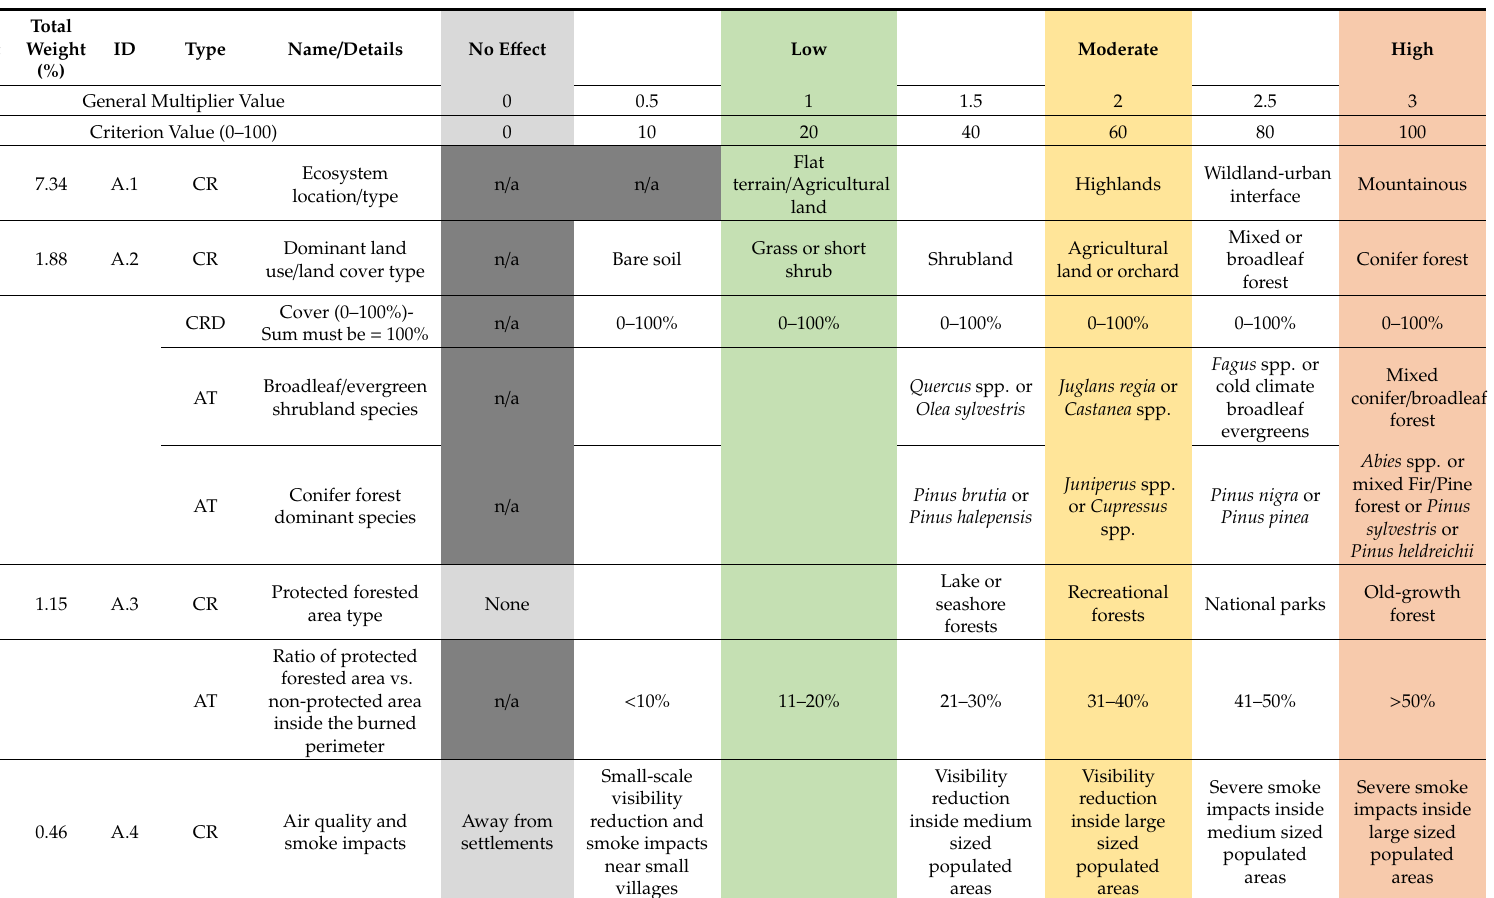
Table A1. Criteria, choices, and weights for the e ff ects on landscape and vegetation fire e ff ects category. CR: criterion; CRD: criterion descriptor; AT: additive term; GM: general multiplier. Light gray: Choices with no e ff ect; Dark gray: N / a, denotes a non-applicable or not available selection; Green: Choices with low e ff ect; Yellow: Choices with moderate e ff ect; Red: Choices with high e ff